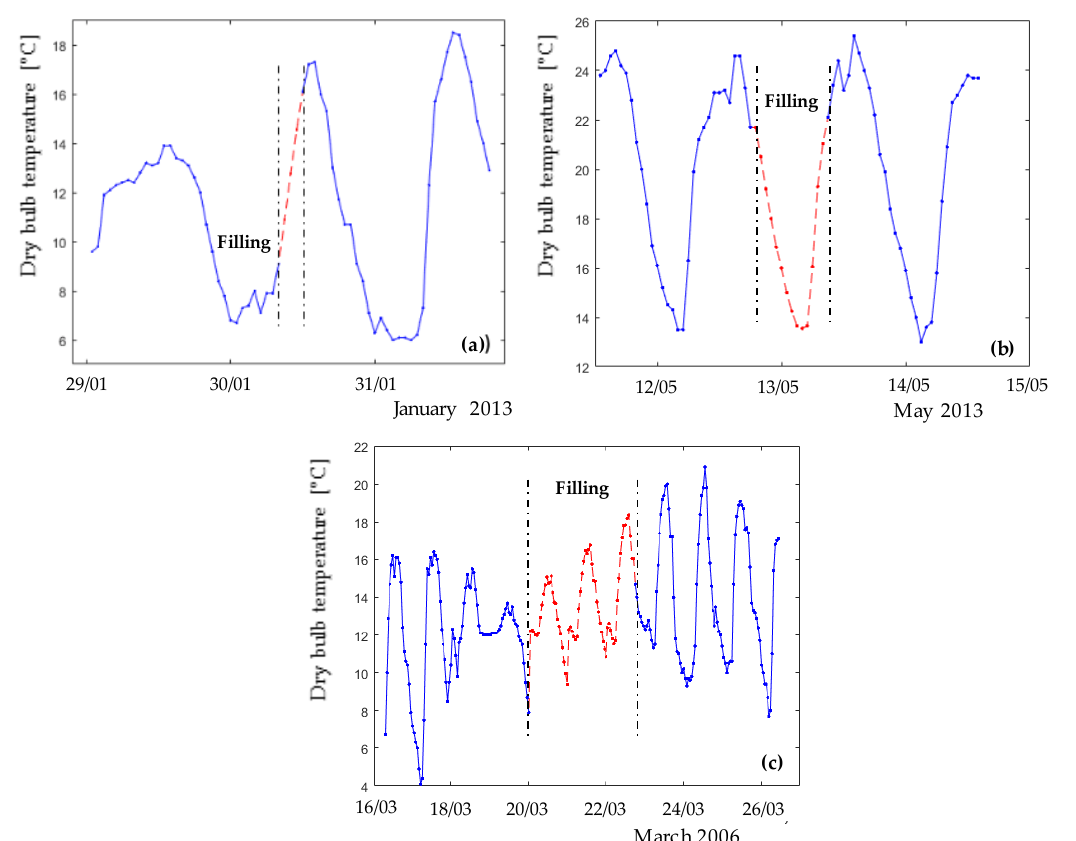
Figure 5. Examples of the filling procedure. ( a ) 0–6 h gaps. ( b ) 6–24 h gaps, ( c ) 24–72 h gaps (the dotted lines correspond to the data added through the filling procedure).